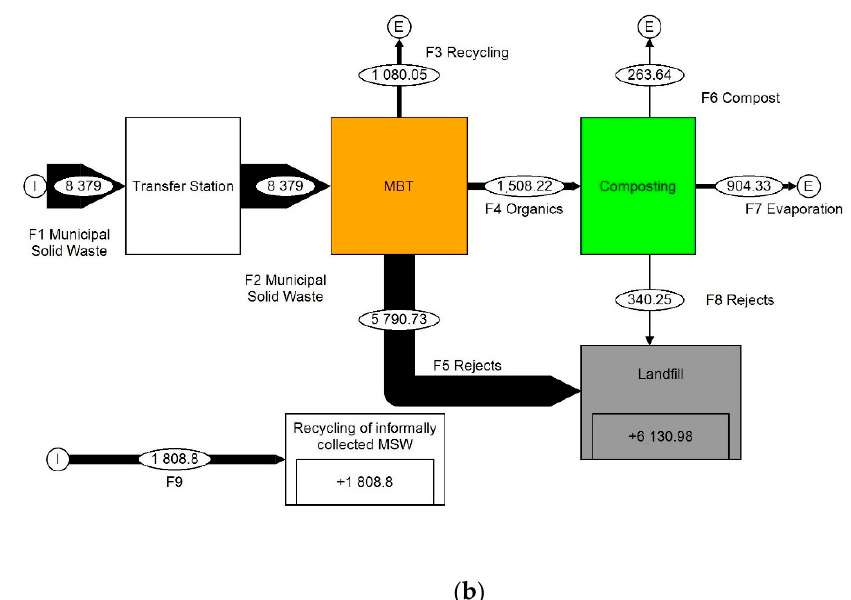
Figure 2. Mass flows of waste scenarios: ( a ) baseline scenario; ( b ) scenario with MBT.